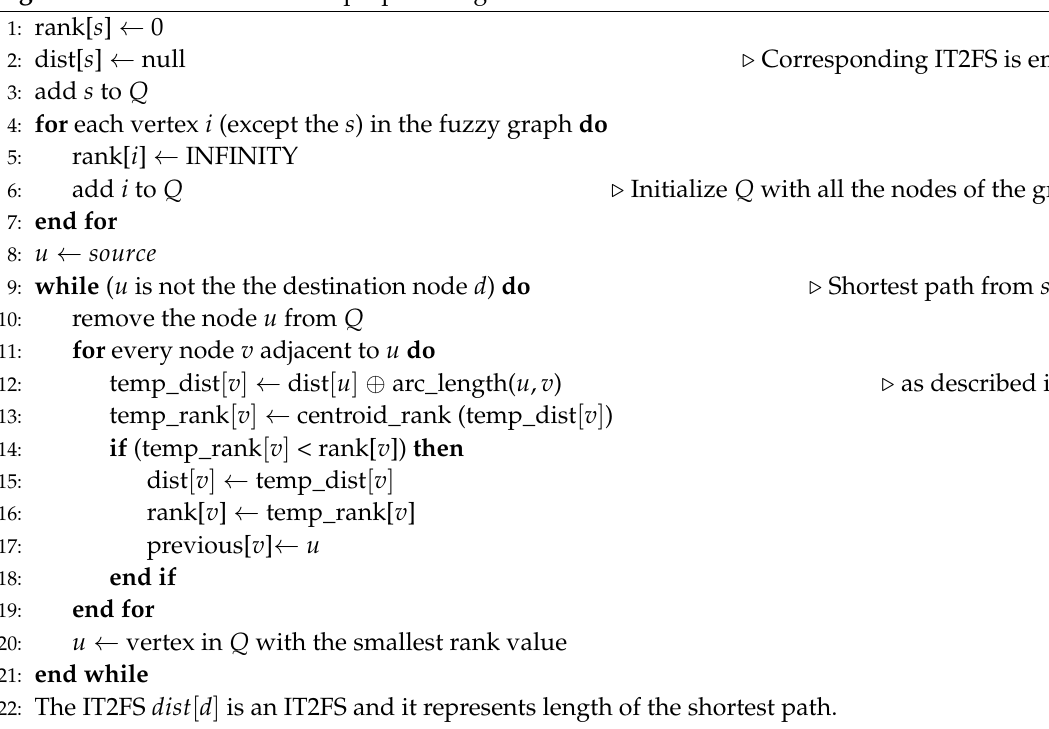
Algorithm 2 Pseudocode of the proposed